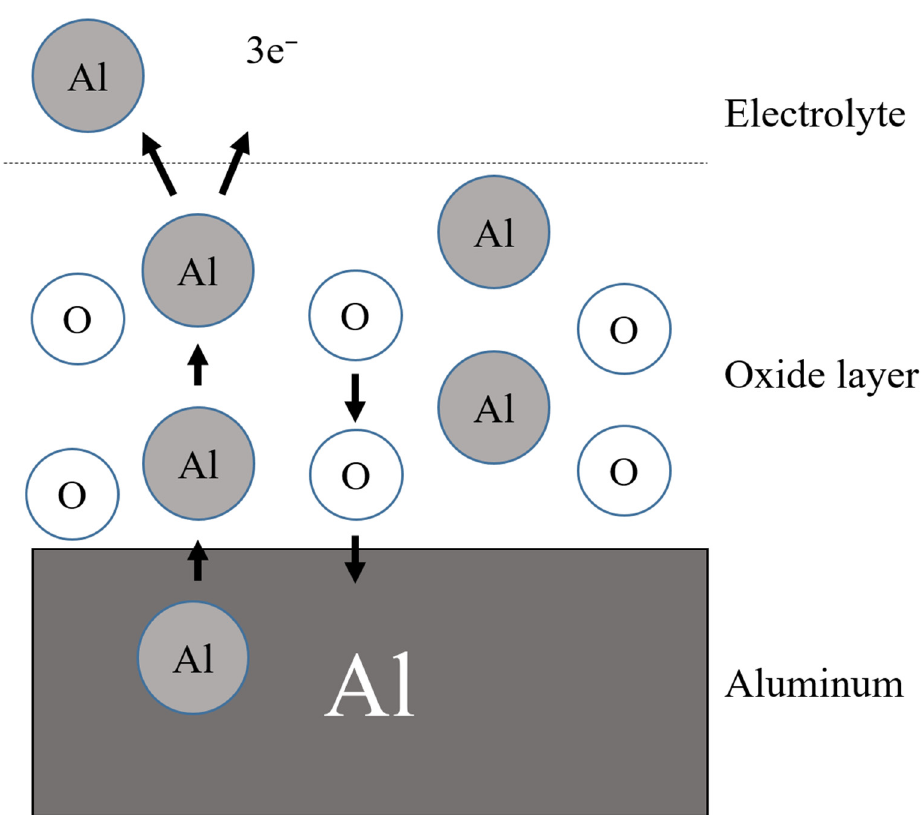
Figure 6. The schematic AAO formation mechanism. During the anodization process, the dissociation degree of water molecules is very low, so the source of oxygen ions is mainly generated by the action of acid radical ions in the electrolyte. When the anions interact with water molecules, the hydrogen ions and hydroxide ions will break to produce hydroxide ions (OH − ) or oxygen ions (O 2 − ). Generally, AAO is anodized in sulfuric acid, oxalic acid, phosphoric acid or chromic acid, with aluminum as the anode and other suitable metals as the cathode. The AAO nanopore structure is modulated by the parameters voltage, electrolyte concentration and time to form various nanostructure. Figure 7 shows the SEM micrographs of AAO nanostructures using different concentrations of oxalic acid [63]. The AAO was performed using a three-electrode electrochemical cell and the potentiostat under two-step direct current anodization at 40V with different concentrations of 0.3, 0.5 and 0.7 M oxalic acid for 1 h, respectively. The pore diameters of AAO analyzed by ImageJ software are 55.1 nm (0.3 M), 55.9 nm (0.5 M) and 56.8 nm (0.7 M), respectively, see Figure 7a–c. The thickness examination at 0.3, 0.5 and 0.7 M of AAO are 16.0 µ m, 19.1 µ m and 22.3 µ m in Figure 7d–f, respectively. The thickness or growth rate of the AAO film increases with the electrolyte concentration due to a general chemical reaction proportional to reactant concentration. The AAO structure grows vertically downward, and the original aluminum metal substrate is beneficial to the parallel capacitor structure. Therefore, most AAO-based humidity sensors are produced with a metal–dielectric–metal structure for capacitance or resistance measurement using the PVD process to contact the electrodes [63–65]. On the other hand, some groups used AAO as a template to synthesize nanocomposite films for humidity sensing, such as the AlPcCl-AAO structure in Section 2.1